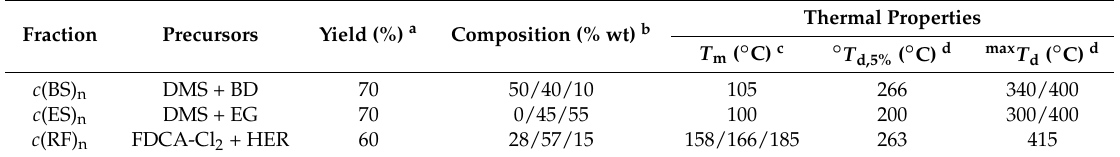
Table 1. Cyclic Oligomers Fractions used for ROP.